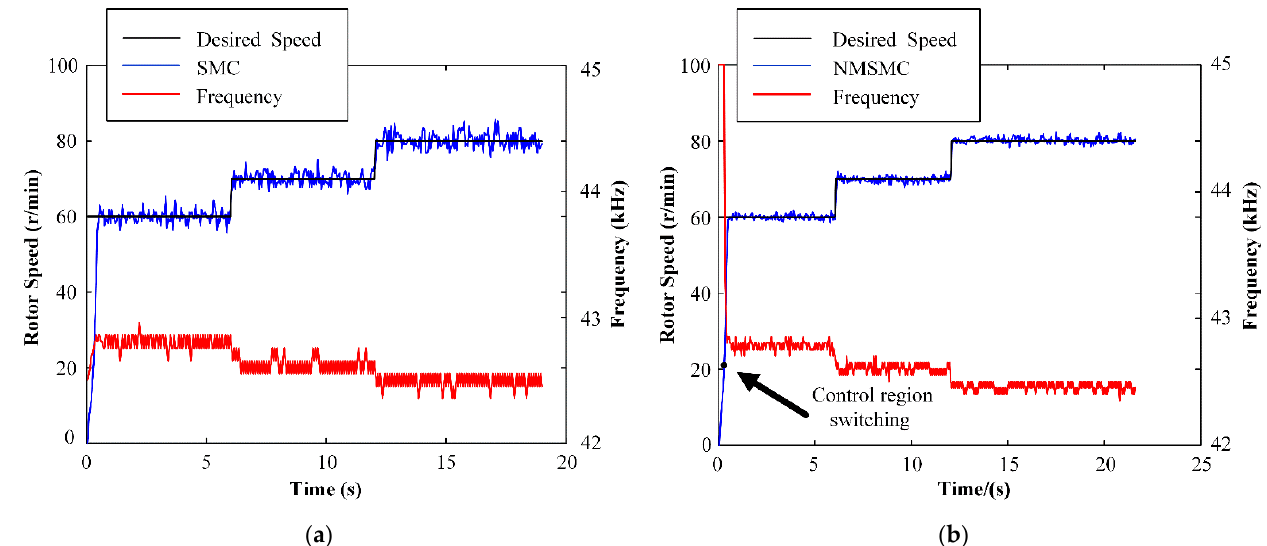
Figure 10. Experiment results of constant speed control: ( a ) SMC; ( b ) NMSMC.